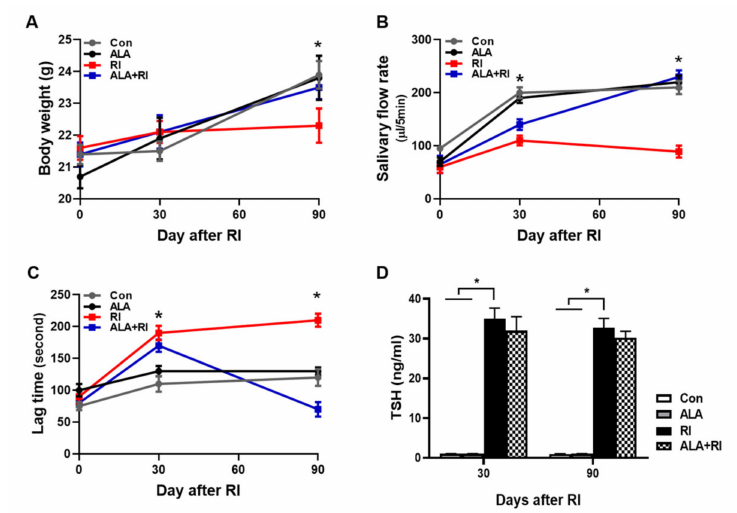
Figure 1. Changes of mouse body weights, salivary flow rate, and lag times after radioiodine (RI) exposure. Mice were subjected to radioiodine (RI, 0.01 mCi / g body weight orally). ALA was administered 24 h 30 min before RI exposure (100 mg / kg body weight, i.p.). ( A ) Body weight, ( B ) salivary flow rate, and ( C ) saliva lag time were measured at each time points after RI exposure. Scoring of salivary flow rate and lag time is described in the “Materials and Methods” section (B, C) The ALA-treated group showed improved lag time and increased saliva secretion relative to the RI only group. ( D ) To verify the e ff ects of ALA on thyroid function following RI therapy, ELISAs for serum TSH were performed (both 30 and 90 days). The serum TSH levels were significantly increased in RI only group and tend to decrease by ALA treatment but not significant. The Kruskal–Wallis test followed by post hoc testing with Dunn’s test was used to examine di ff erences between groups. In all analyses, * P < 0.05 was taken to indicate statistical significance.